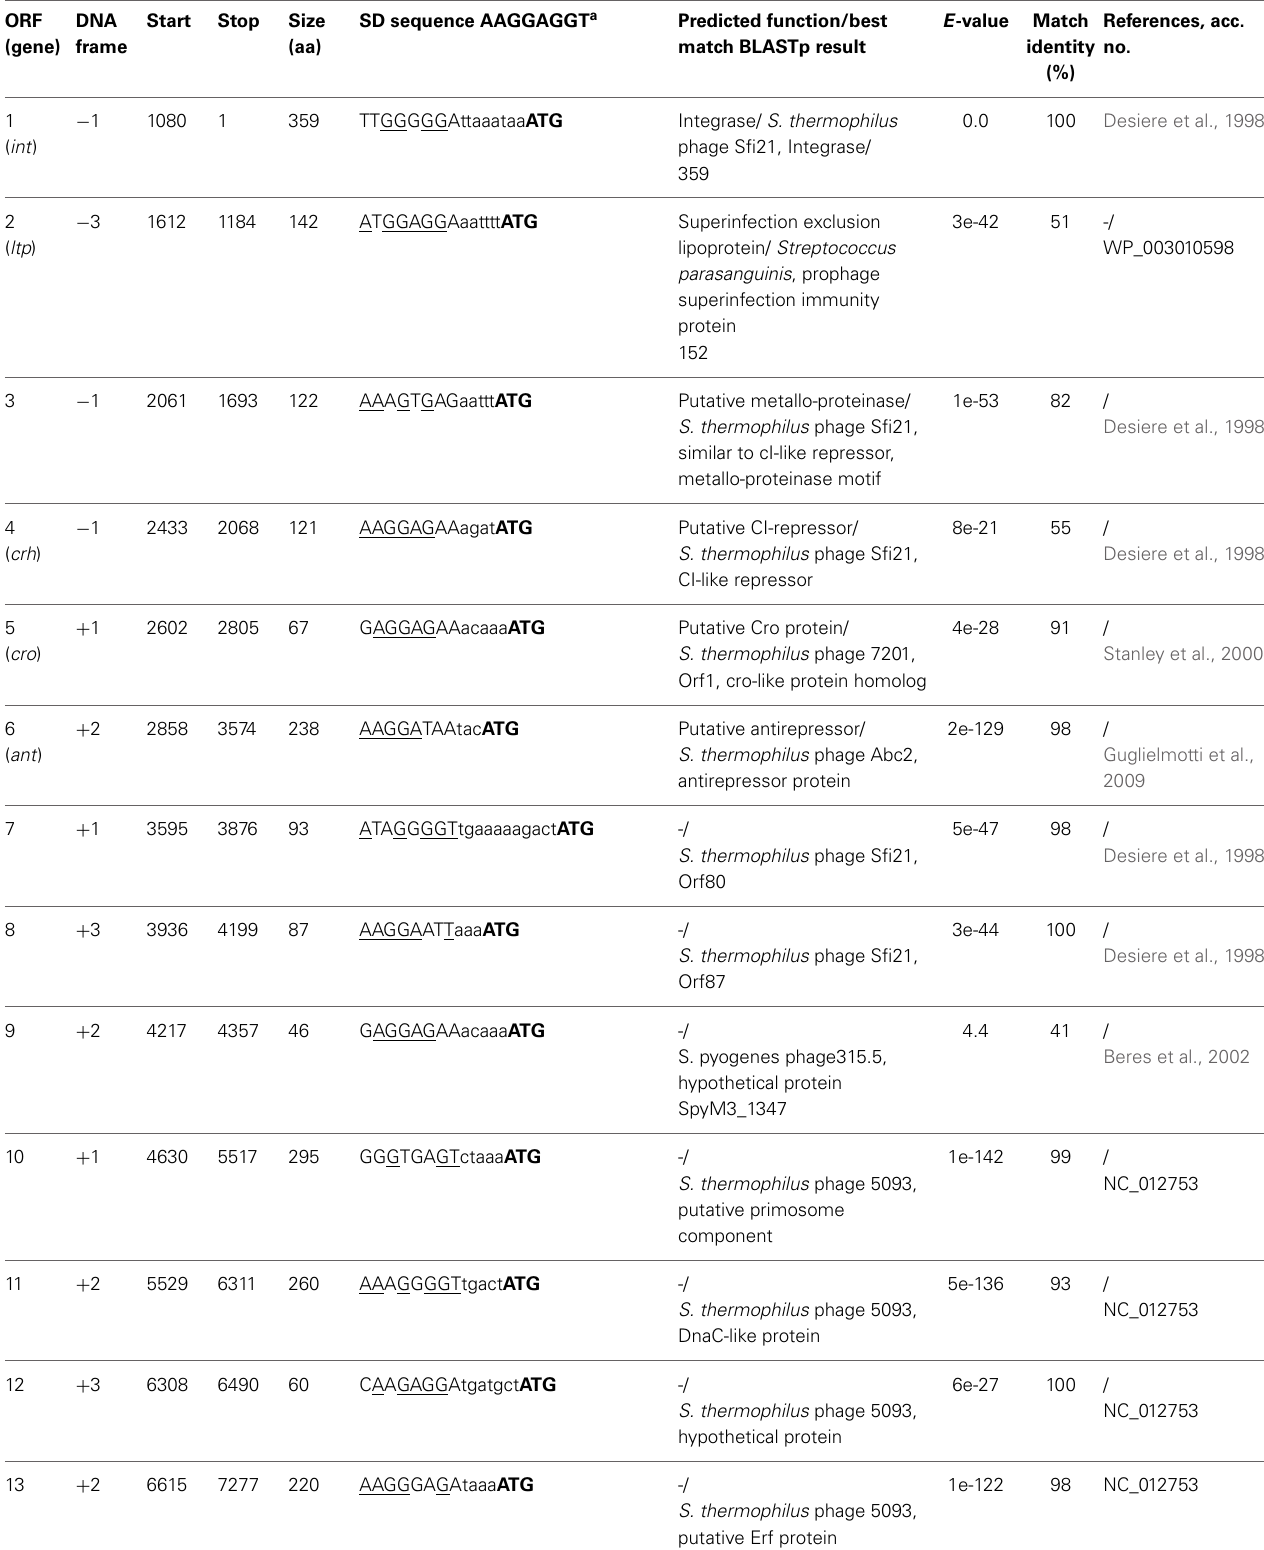
Table 3 | Features of phage TP-J34 orf s and putative functions of their products. ORF DNA (gene)